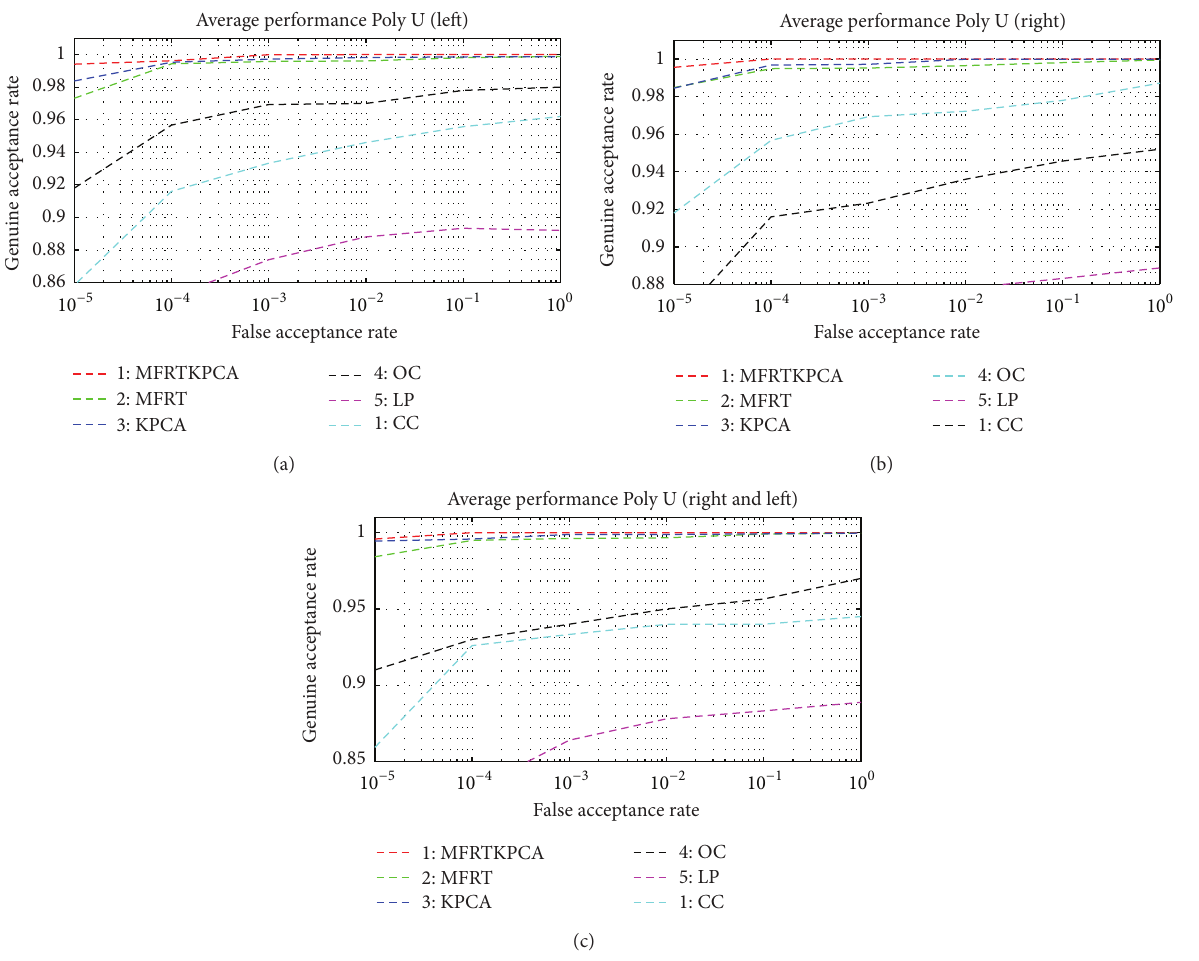
Figure 7: Receiver operating characteristics from the Poly U multispectral palm print database: (a) left palm, (b) right palm, and (c) left and right palm.